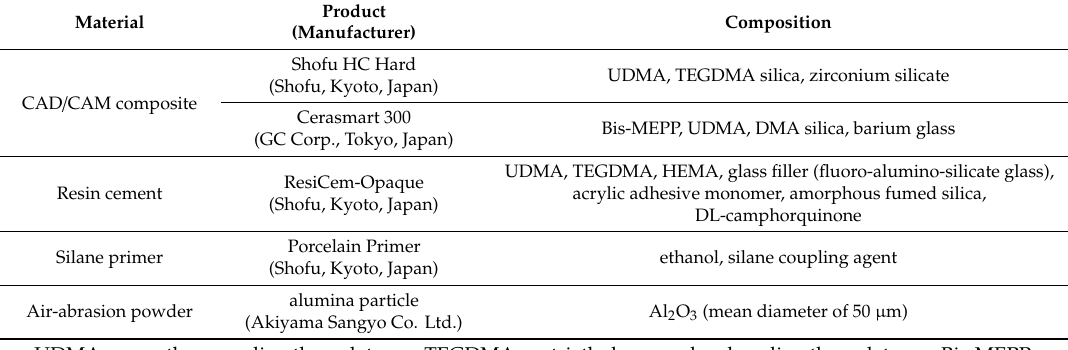
Table 1. Materials used in this study. The composition of each material refers to the manufacturer’s